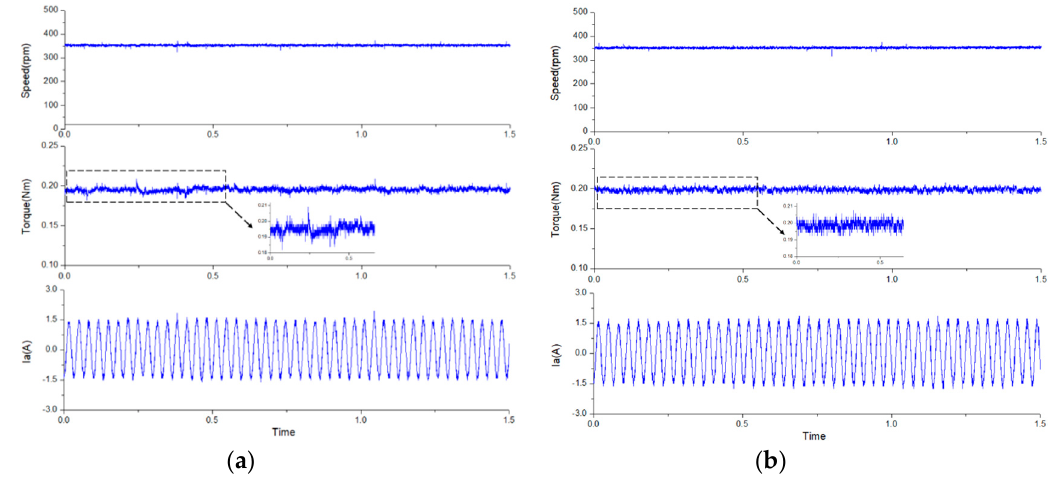
Figure 14. The steady-state response for 0.2 Nm load at a speed of 350 rpm: ( a ) the traditional PI control, and ( b ) the proposed modified MPCC.